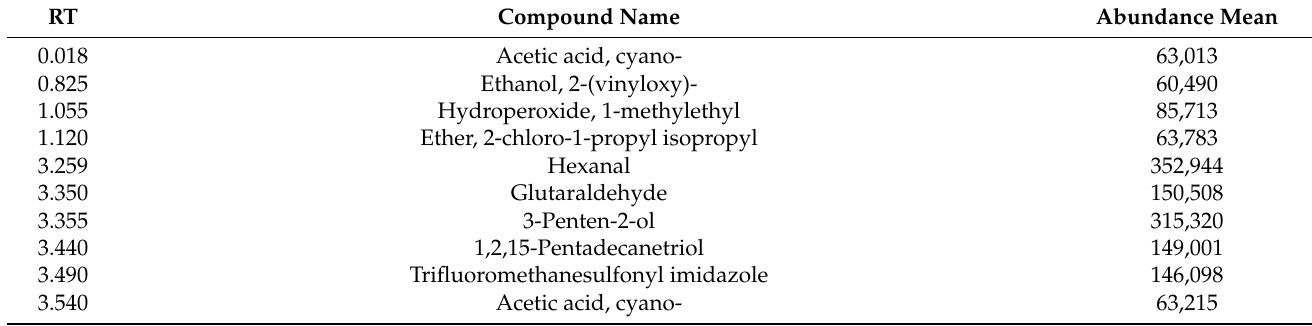
Table A4. Results for the SGM sample fingerprint determination with indication of the retention time (RT) and abundance mean for every identified